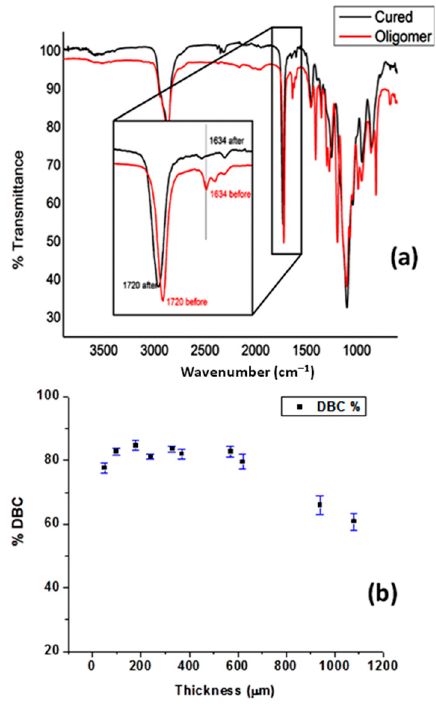
Figure 3. ( a ) Fourier transform infrared (FT-IR) spectra of neat PEGDA before and after ultraviolet (UV) curing. ( b ) The % DBC (double bond conversion) of neat PEGDA as a function of the film thickness.